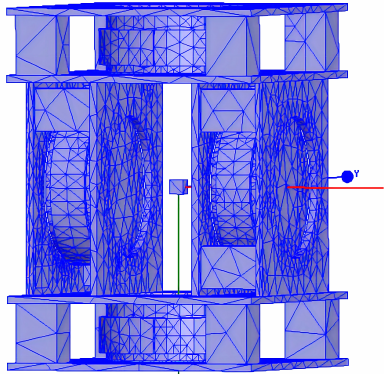
Figure 7. Mesh division diagram of the magnetic field generator.